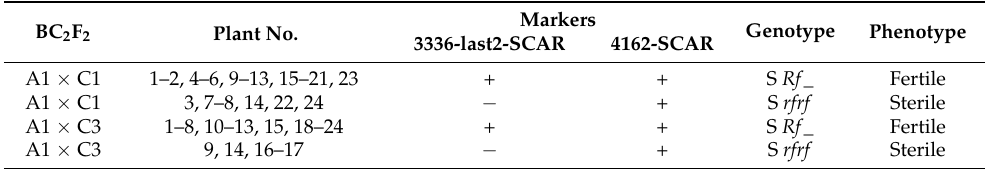
Table 3. The presence of DNA bands of BC 2 F 2 A1 × C1 and BC 2 F 2 A1 × C3 under 3336-last2- SCAR and 4162-SCAR markers with their identification of genotype and phenotype.